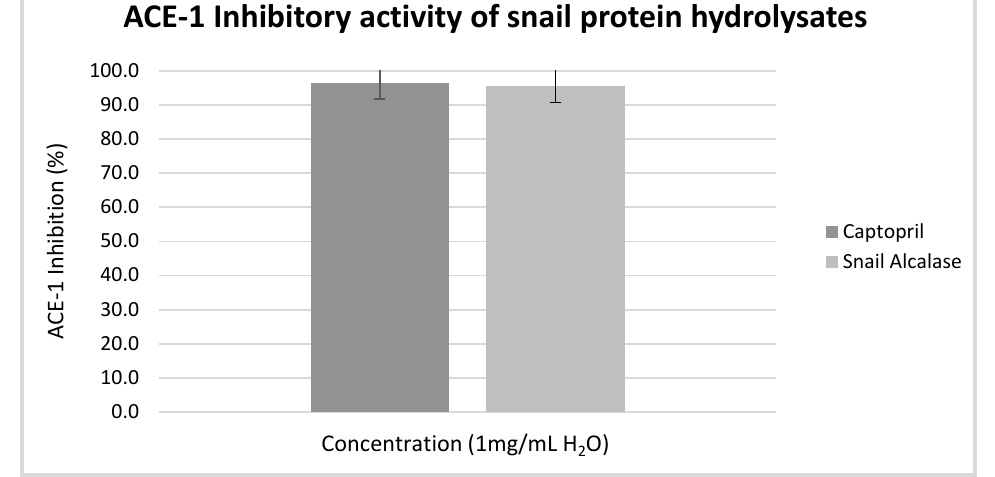
Figure 1. ACE-1 inhibition by snail protein hydrolysate compared to the control Captopril © .